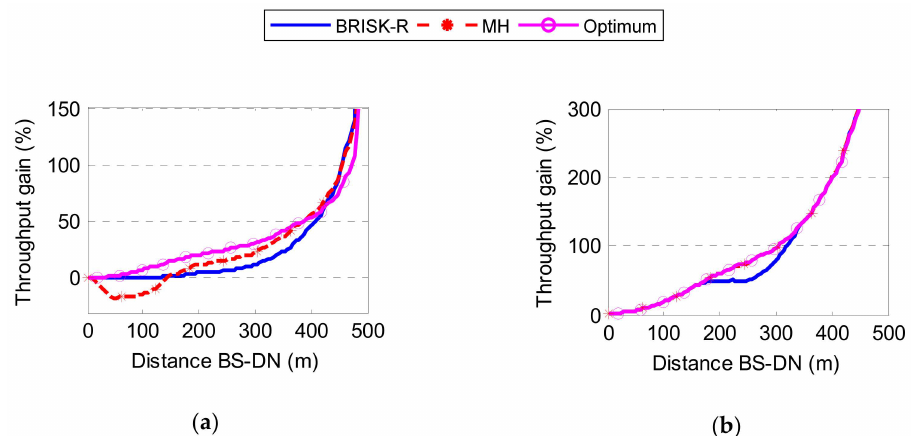
Figure 12. Throughput gain obtained with the mode selection schemes with respect to SH—web tra ffi c & circularly symmetric scenario. ( a ) 15 RN scenario; ( b ) 1000 RN scenario.